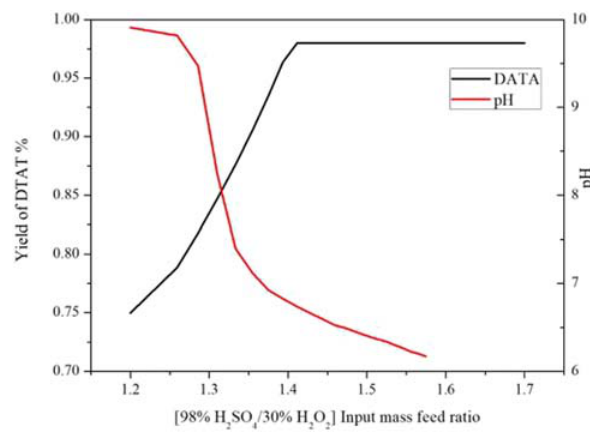
Figure 7: Relationship between the feed ratio of H 2 SO 4 /H 2 O 2 and the DATA yield and pH in the